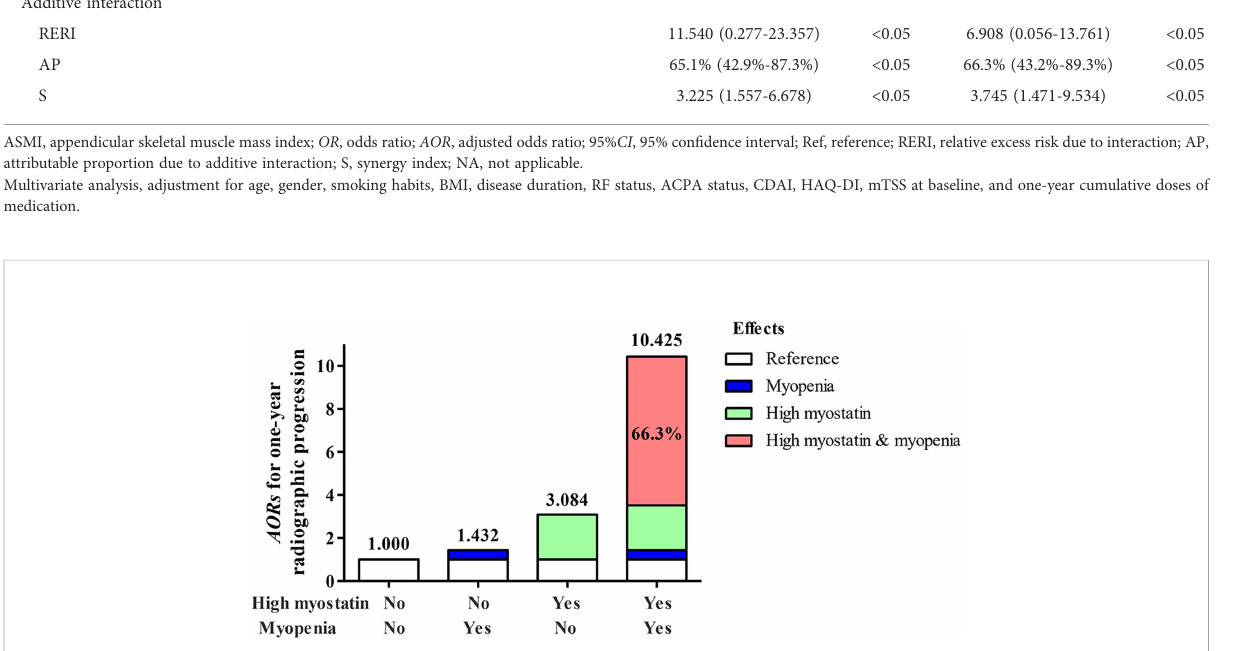
FIGURE 4 Illustration of the additive synergistic interaction of high myostain and myopenia for one-year radiographic progression. AOR , adjusted odds ratio, adjustment for age, gender, smoking, BMI, disease duration, RF status, ACPA status, CDAI, HAQ-DI, mTSS at baseline, and one-year cumulative doses of